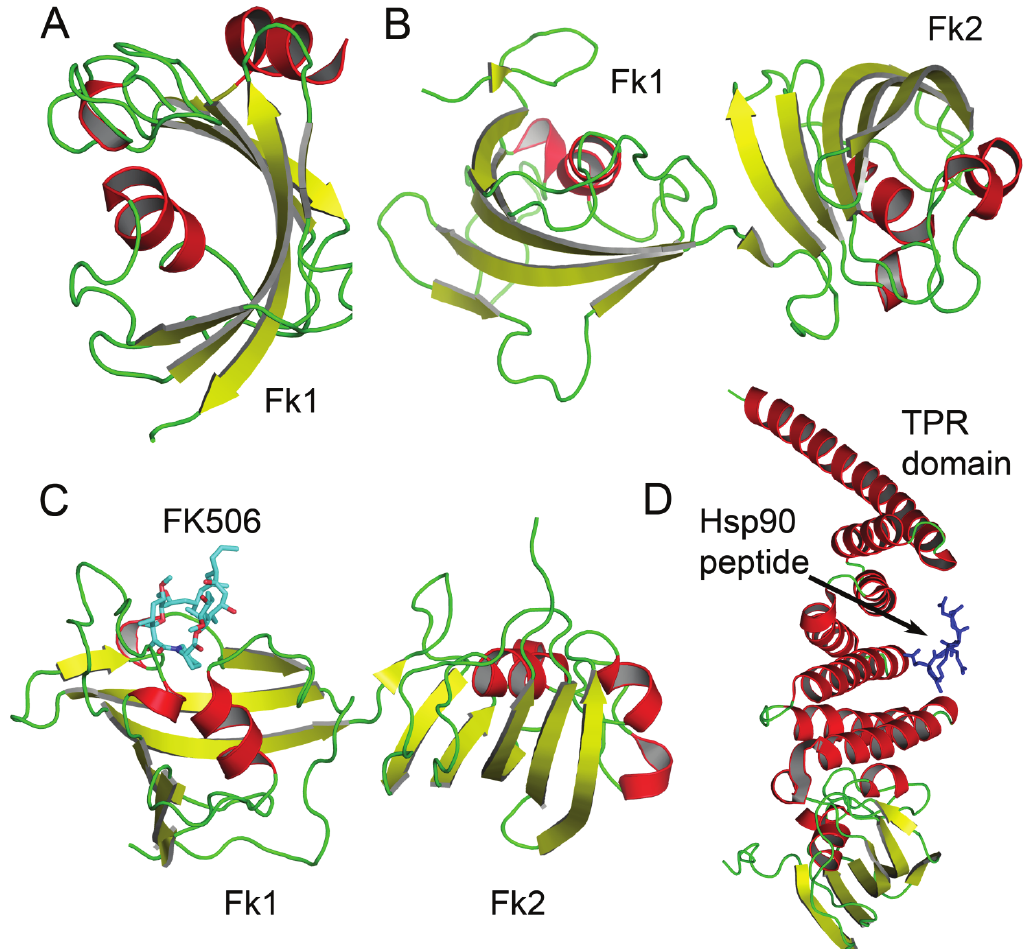
Figure 3. Structures of FKBP domains free and complexed to FK506 and a Hsp90